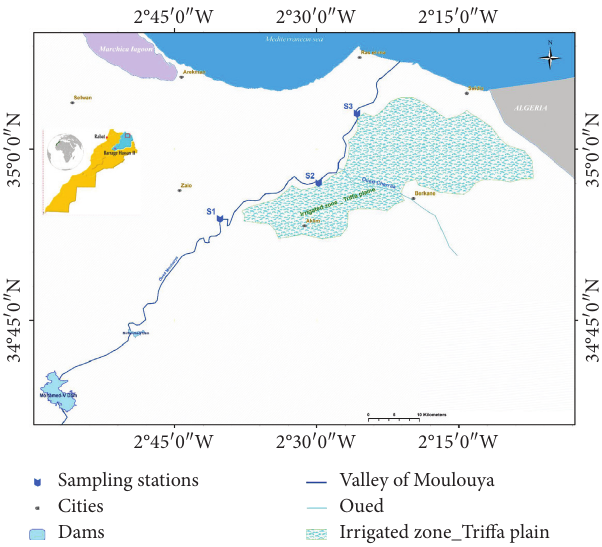
Figure 1: Localization map of the study area and location of sampling stations